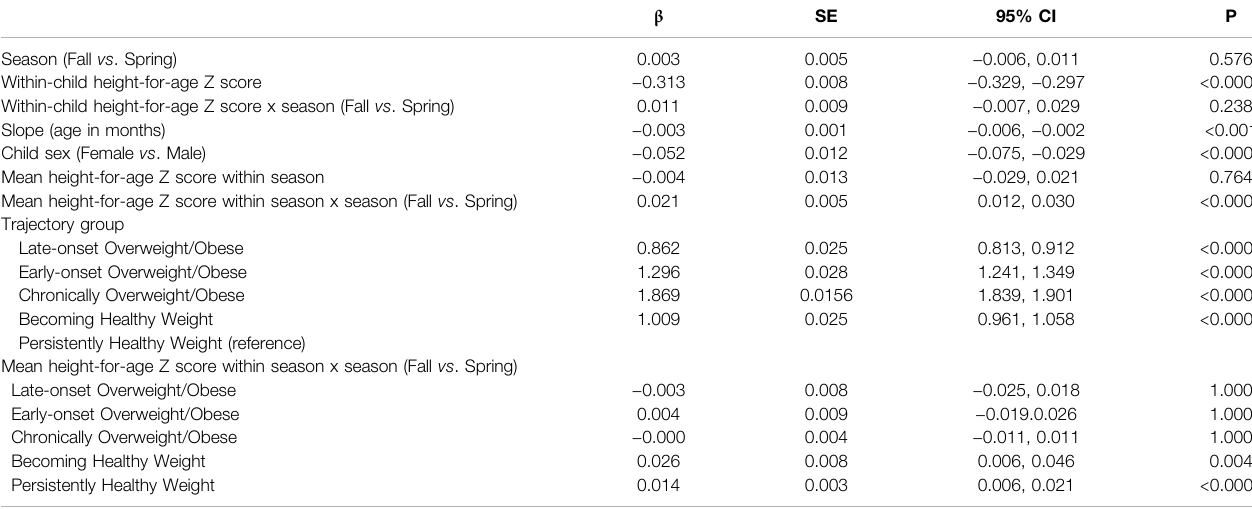
TABLE 3 | Mixed model fi ndings testing the association of height-for-age Z scores with the outcome of BMIz.